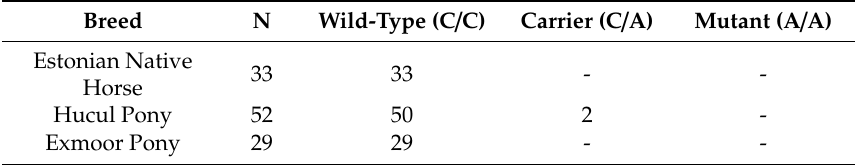
Breed N Wild-Type (C / C) Carrier (C / A) Mutant (A / A) Estonian Native